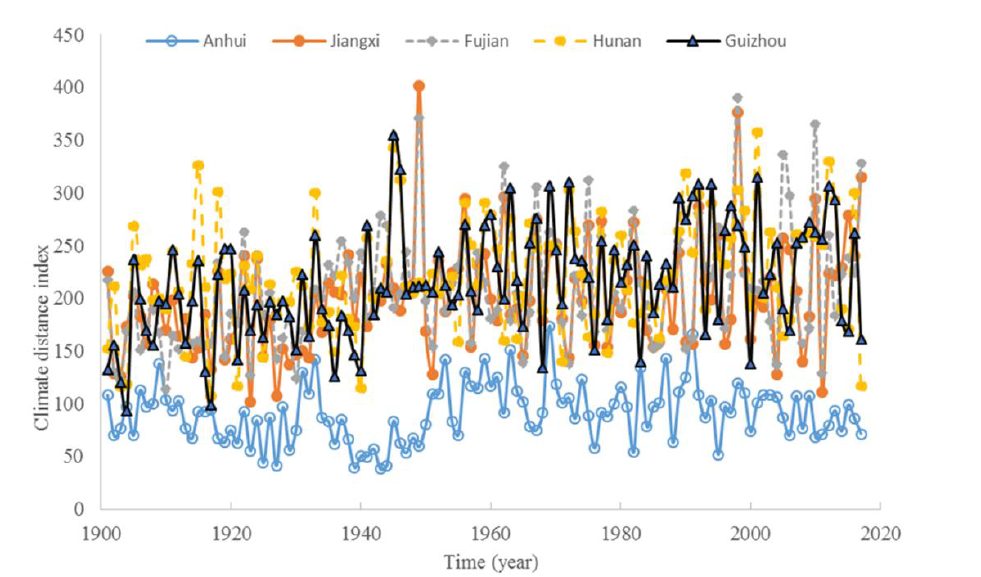
Figure 8. The distance index for air temperature between Zhuji and other regions and climate distance between Zhuji and other regions. Table 2. Correlation coefficients (R 2 ) between Zhuji and other regions in the monthly air temperature and precipitation from 1901 to 2017. Anhui Jiangxi Fujian Guizhou